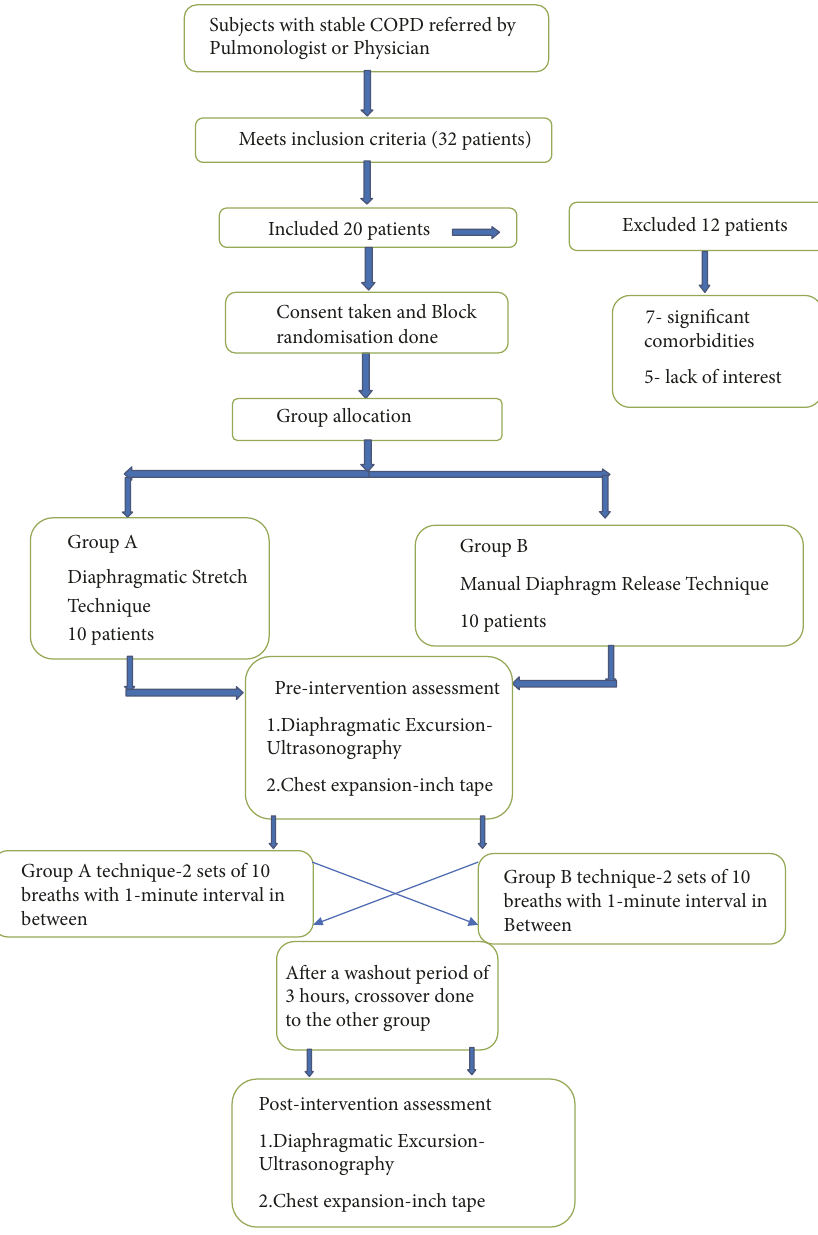
Figure 1: Flow diagram of the